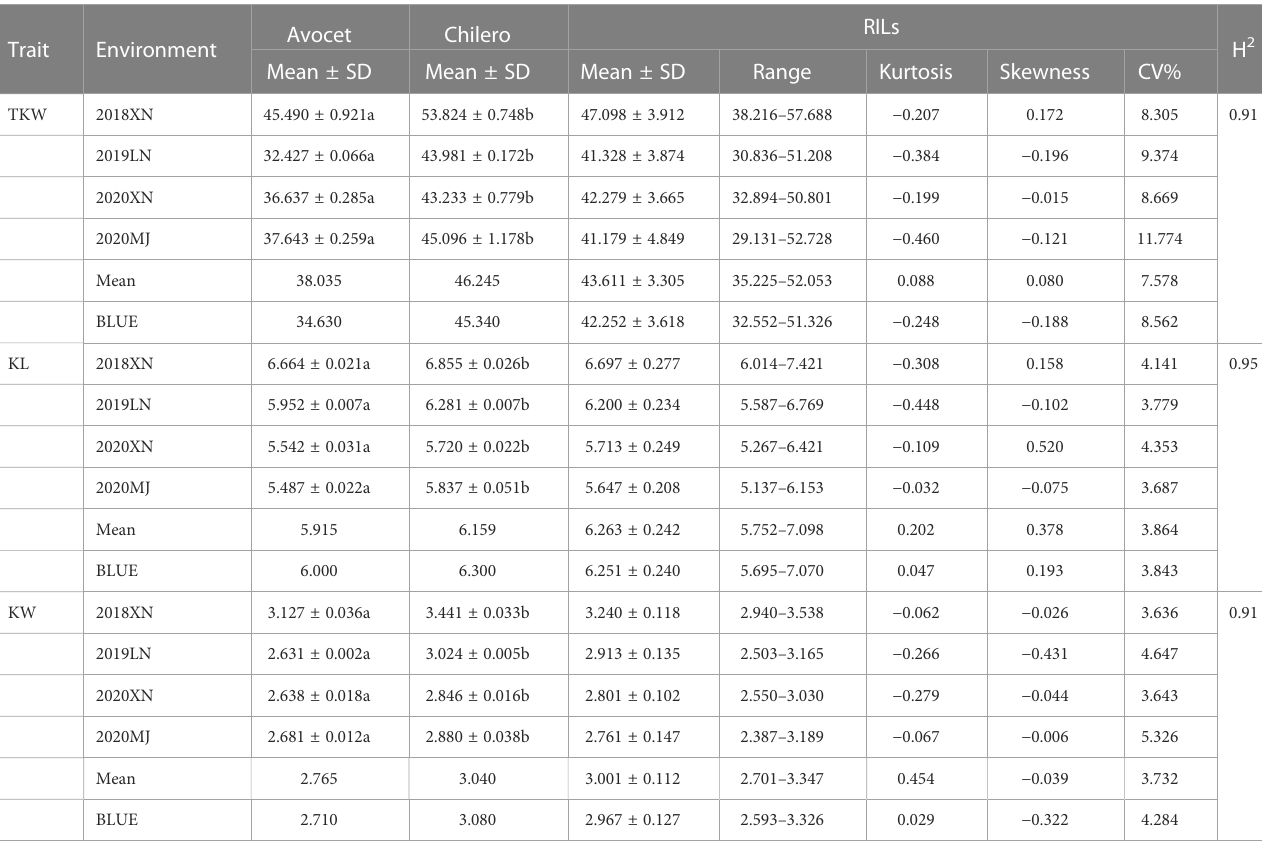
TABLE 1 Descriptive statistics of the parental genotypes and RILs for different kernel traits in four environments.